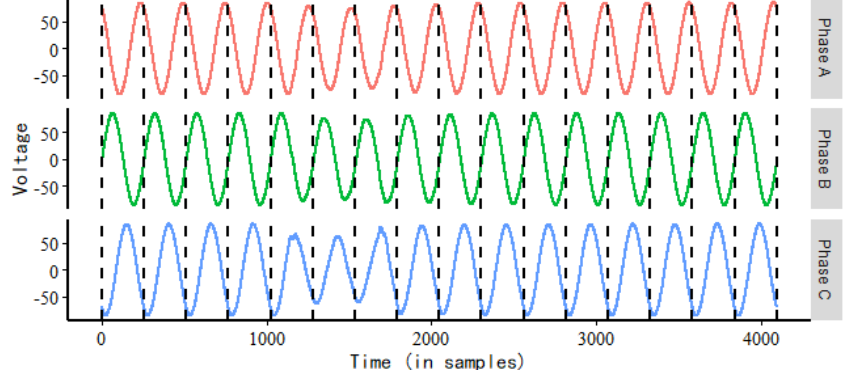
Figure 2. Voltage data (id 01) are divided into L segments according to K